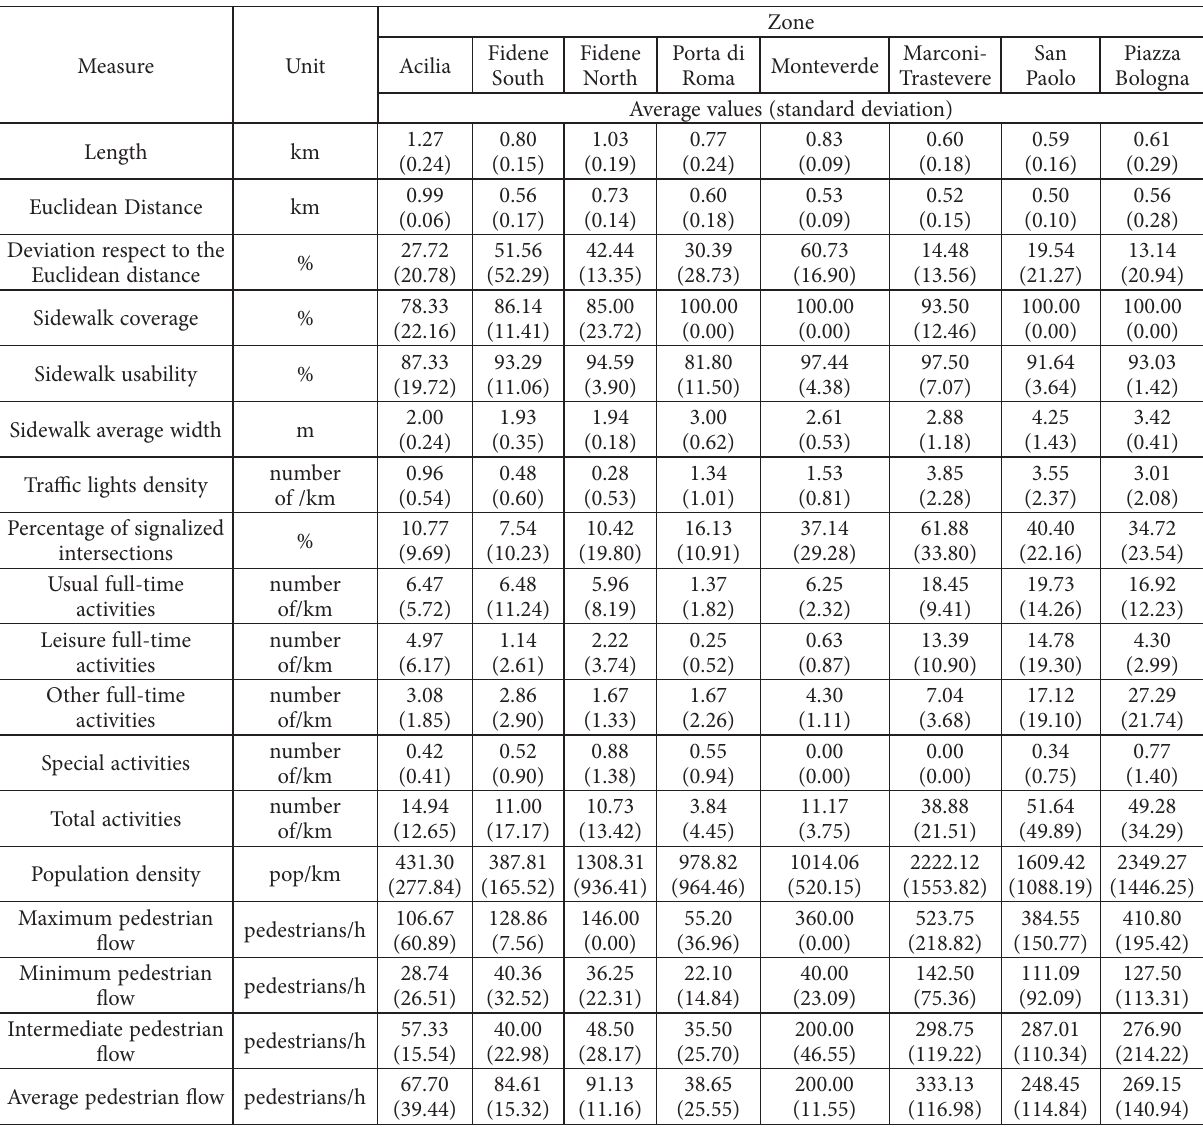
Table 3. Average values of quality measures collected in each zone